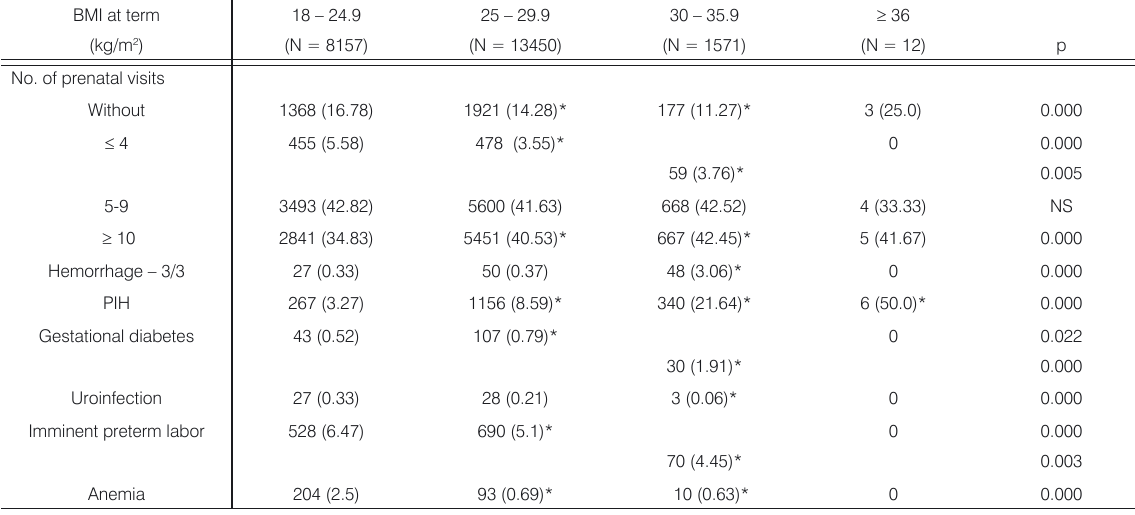
Table 3. Complications during